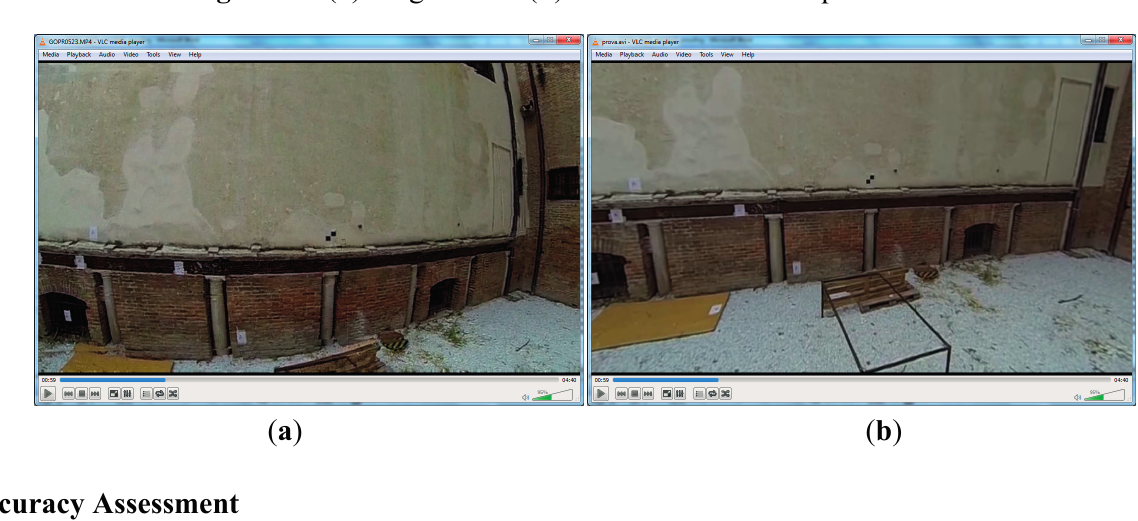
Figure 14. ( a ) Original and ( b ) undistorted video